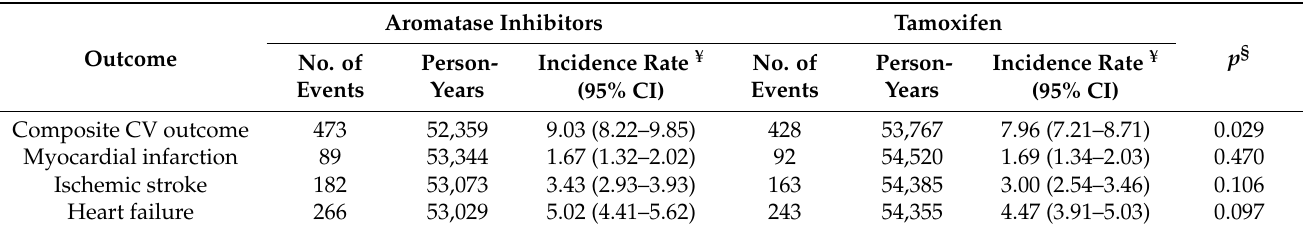
Aromatase Inhibitors Tamoxifen